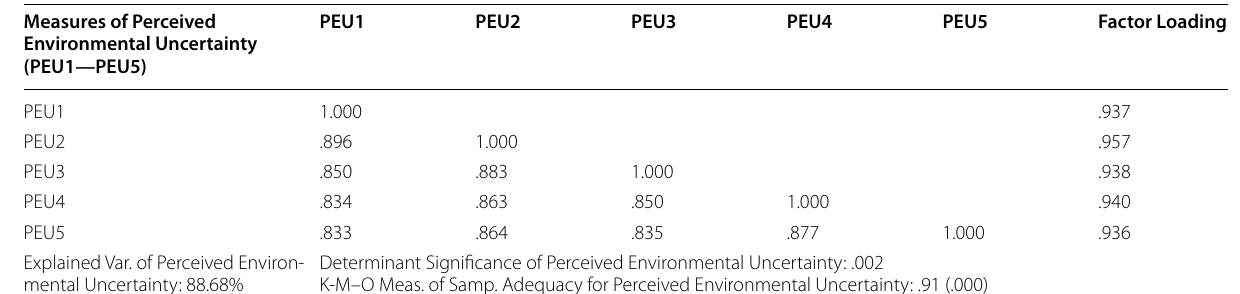
Explained Var. of Perceived Environ- mental Uncertainty: 88.68% Eigen-Value of Perceived Environ- mental Uncertainty: 4.434 Measures of Competition Intensity (CI1—CI4)